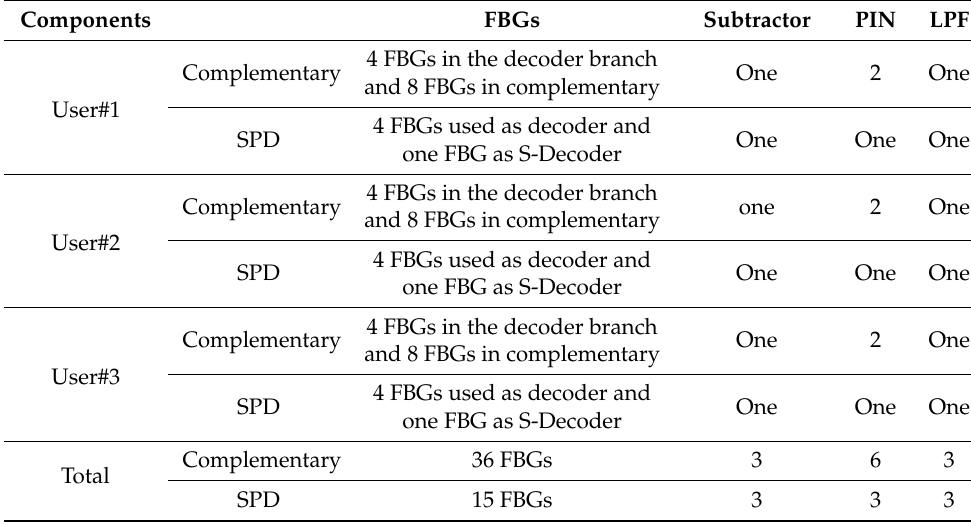
Table 5. Required components for CDS and SPD